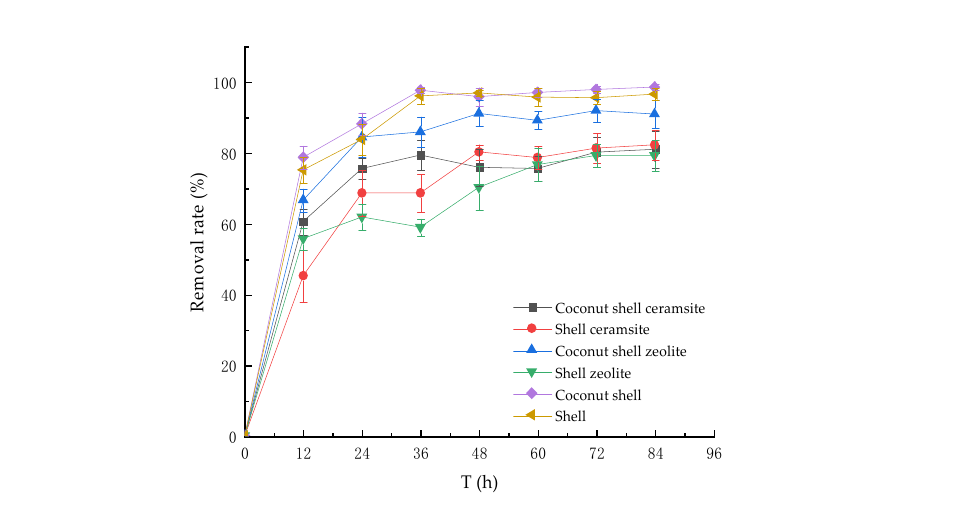
Figure 6. The removal effect of biochar-constructed wetland on total phosphorus.